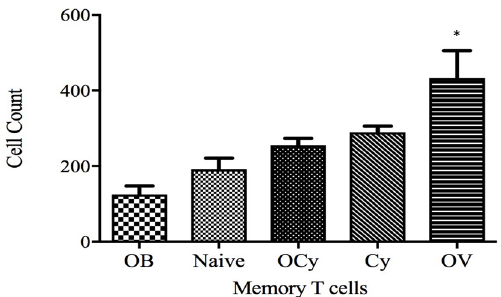
Figure 10. Analysis of the central memory T cell population in naïve mice and those receiving blank microparticles (OB), cyclophosphamide (i.p., 50 mg/kg), oral vaccine microparticles (OV), and a combination of vaccine and cyclophosphamide (OCy). Spleen samples ( n = 6) were collected 52 days post-inoculation with 4TO7 breast cancer cells. The central memory T cell population was evaluated using fluorescently labeled anti-CD62L antibodies. The animals receiving cyclophosphamide showed significantly lower count of me mory T cells (* p < 0.01) .